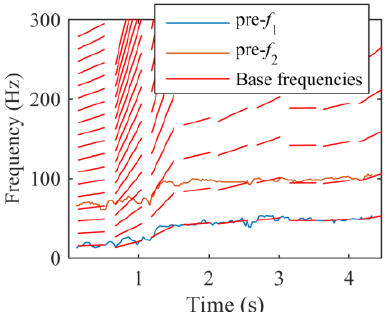
Figure 8. Outer race fault case: ( a ) TFR of lower frequency band signal, ( b ) TFR of envelope of resonant frequency band signal, ( c ) extracted IF ridges from ( a ) using FPO, and ( d ) extracted IF ridges from ( b ) using FPO.